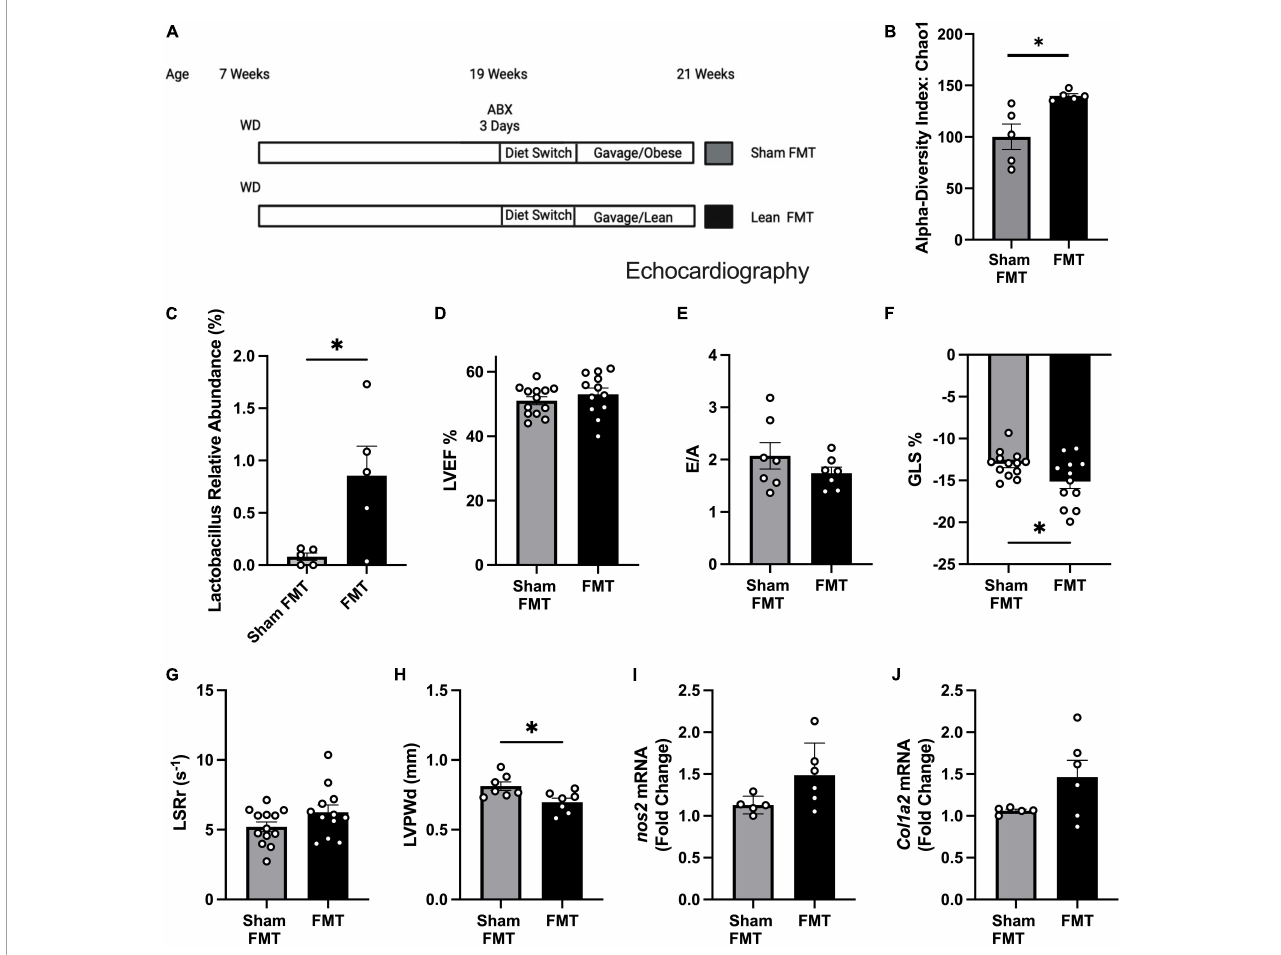
FIGURE2 Fecal microbiome transplant (FMT) treatment improved diastolic dysfunction and cardiac hypertrophy in obese pre-HFpEF mice. (A) Experimental paradigm, C57BL/6J mice fed WD for 12 weeks, followed by broad-spectrum antibiotic treatment for 3 days mice were gavaged daily for 2 weeks with feces either from obese mice (sham FMT group) or from lean mice (FMT group), (B) alpha diversity index (Chao1), (C) Lactobacillus relative abundance (%), (D) representative echocardiography measurement of left ventricle ejection fraction (LVEF), (E) ratio between mitral E wave to A wave (E/A), (F) global longitudinal strain (%GLS), (G) longitudinal strain rate reverse (LSRr) (s - 1 ), (H) left ventricle posterior wall diameter during diastole (mm). (I,J) mRNA levels of nos2 and col1a2 in hearts of mice from different experimental groups. Statistical analysis was done using unpaired student’s t -test. Data